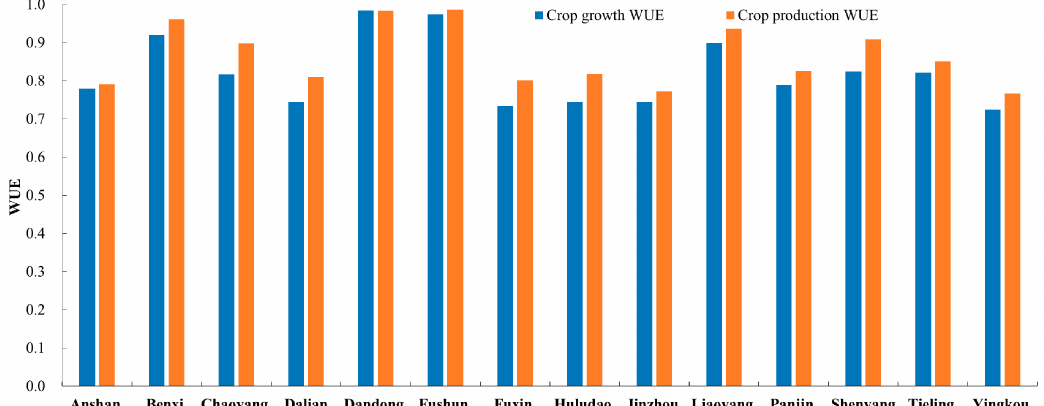
Figure 6. Annual average crop growth WUE and production WUE of all cities in Liaoning Province.